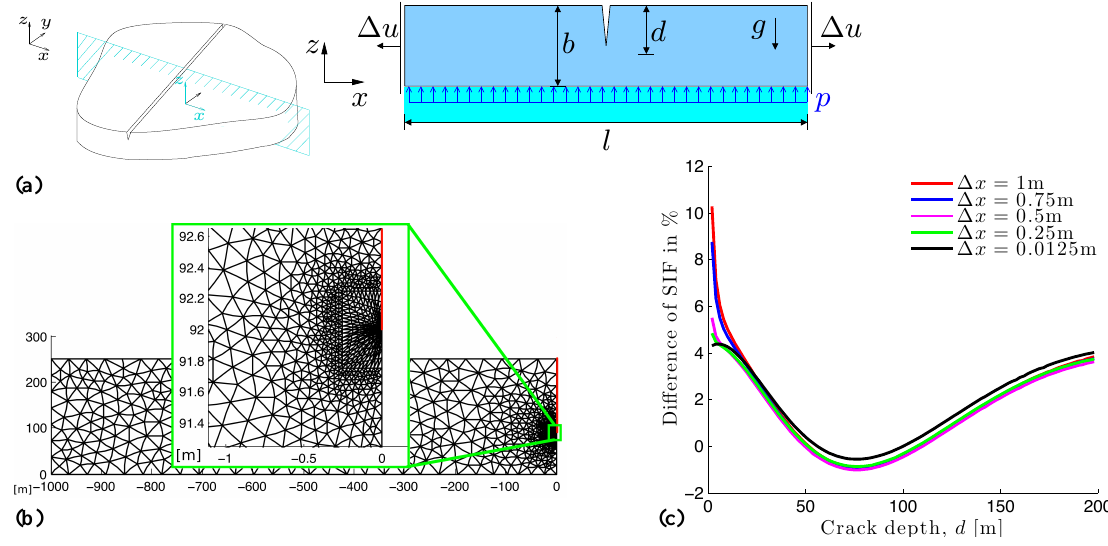
Fig. 1. (a) Model geometry for dry cracks. (b) Discretization in entire geometry with focus at crack tip. (c) Difference between numerical simulation and analytical result for different mesh sizes. ( 1x = element edge length at crack tip).